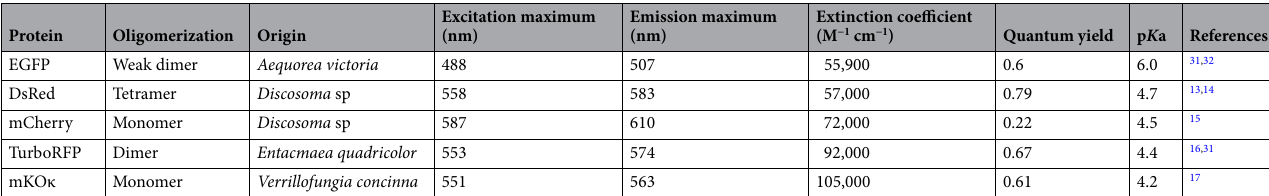
Table 1. Reported properties of fluorescent proteins.